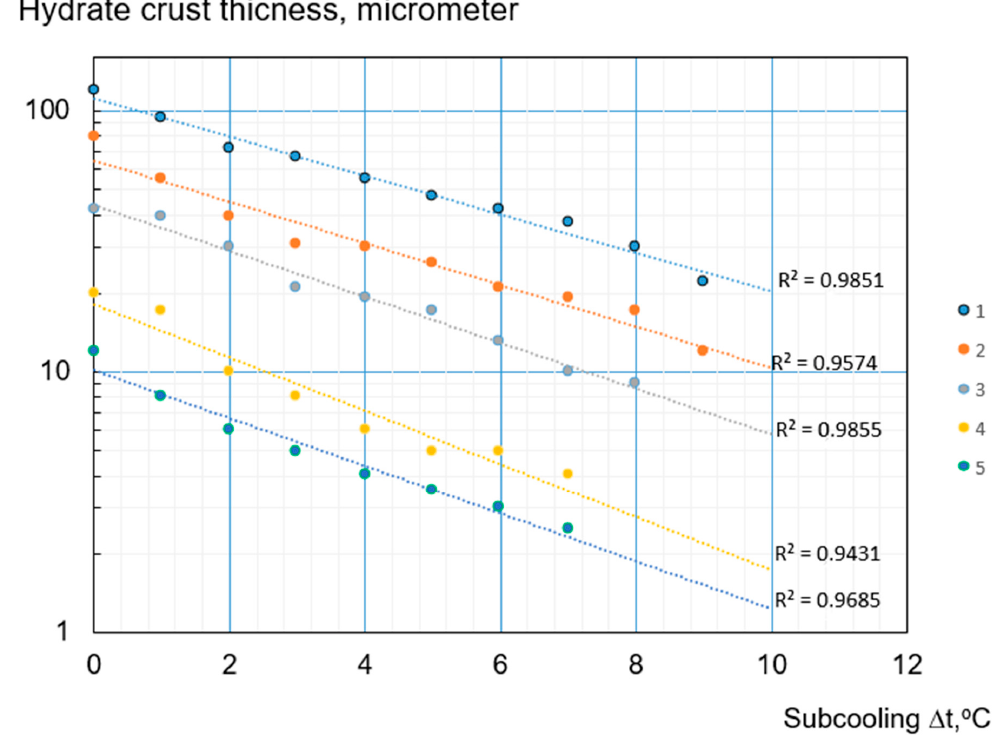
Figure 3. Dependence of crust thickness on temperature and pressure: 1-P = 2.5 MPa; 2-P = 3 MPa; 3-P = 4 MPa; 4-P = 5 MPa; 5-P = 7.5 Mpa.